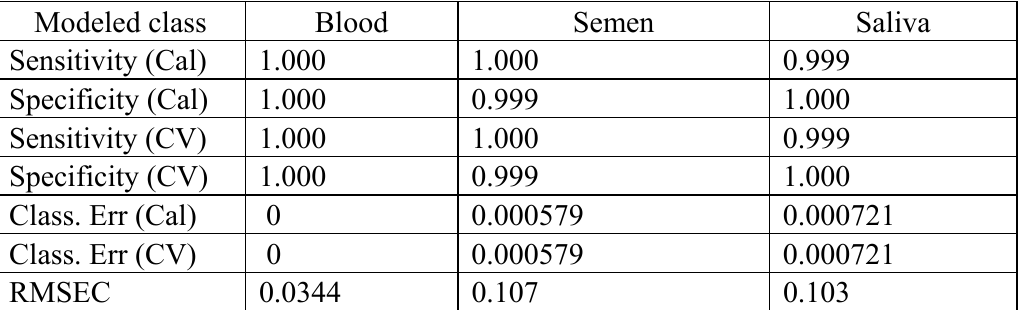
Table 1. Sensitivity and specificity of PLS-DA. Values calculated for calibration (self- prediction, Cal) and cross-validation results